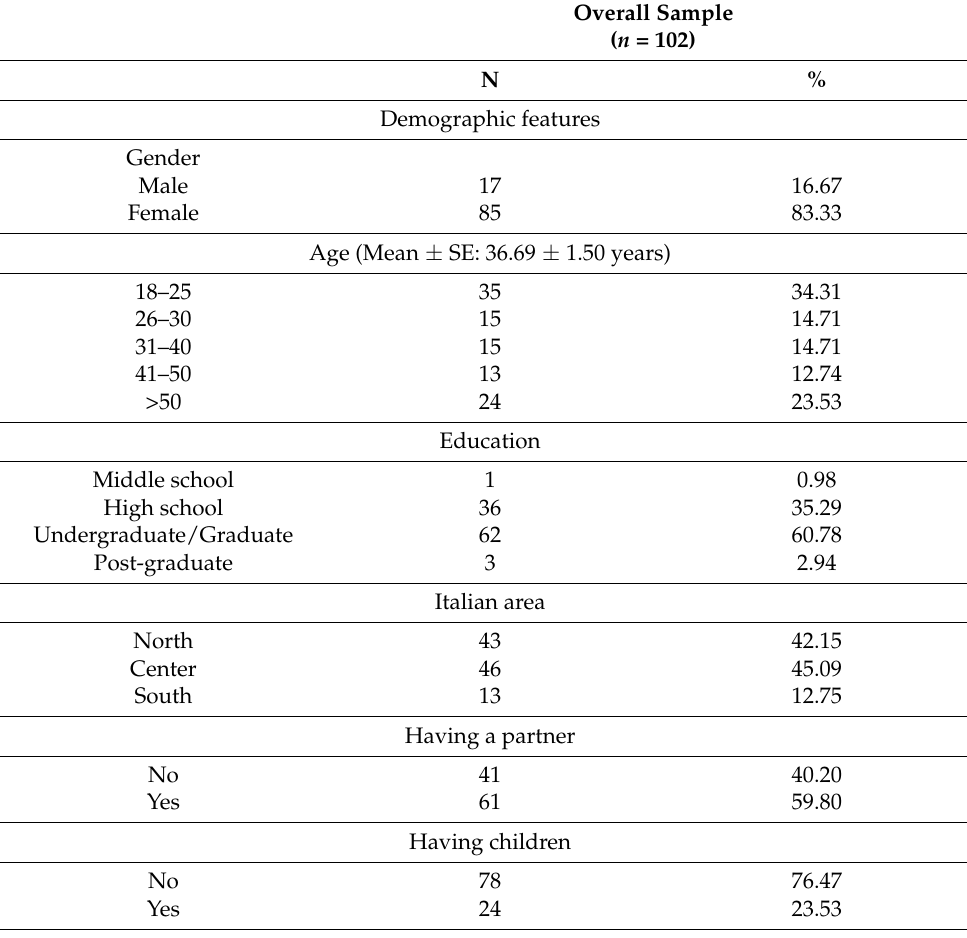
Table 1. Demographic characteristics of the